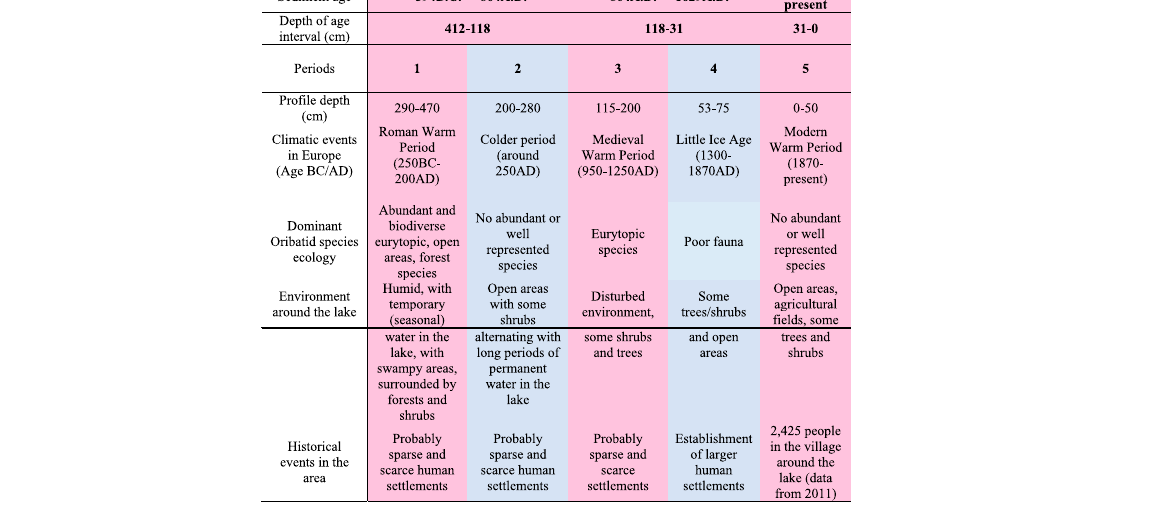
Frontiers in Earth Science |